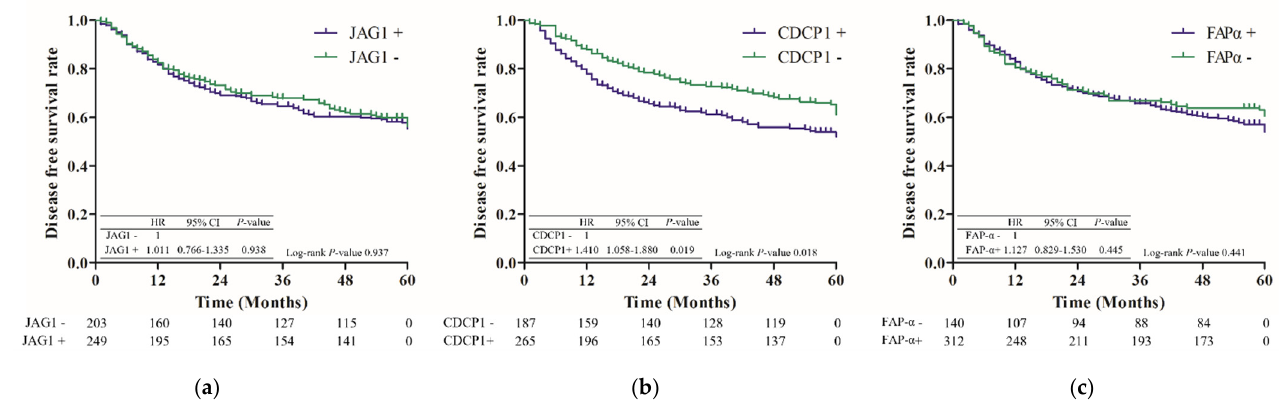
Figure 2. Disease free survival after surgery according to biomarker expression. ( a ) JAG1; ( b ) CDCP1; ( c ) FAP- α .